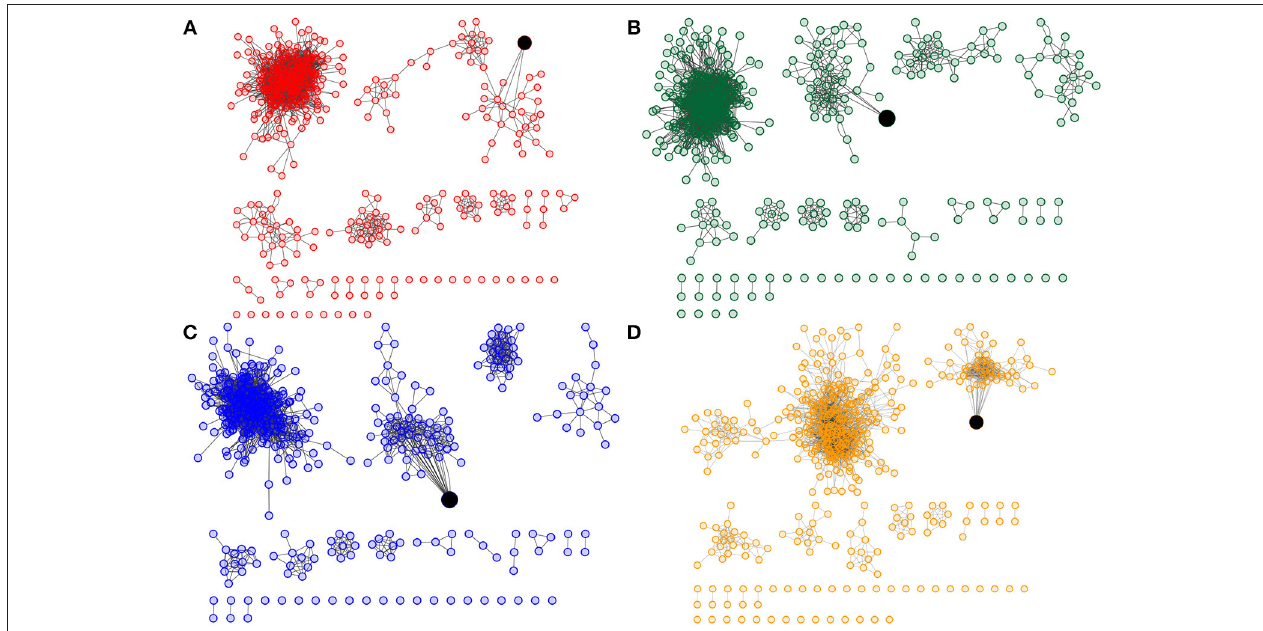
FIGURE 3 | Subnetworks of core genes shared by all breast cancer networks have different connections. (A–D) Show the 453 core genes for Luminal A, Luminal B, Basal and HER2-enriched subtypes. All subnetworks have a component with IRF8 transcription factor (shown in